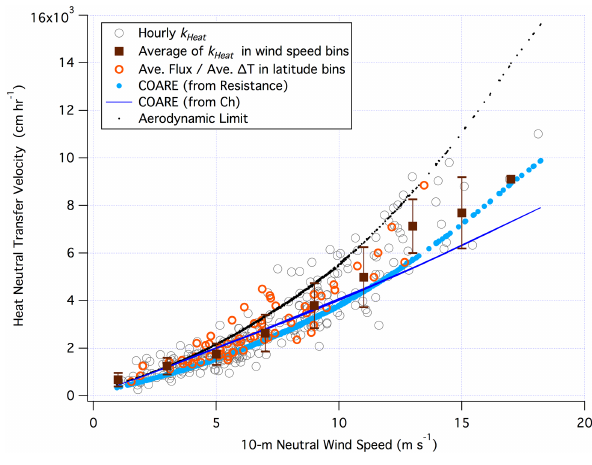
Figure 5. Measured heat transfer velocity vs. wind speed. Three approaches of data averaging are shown (see text for details). For clarity, only hours when 1T >1 ◦ C and relative wind direction be- tween − 30 and 100 ◦ are shown. Error bars indicate standard devia- tions from the bin averages. Two parameterizations of heat transfer from the COARE model as well as the aerodynamic limit are also